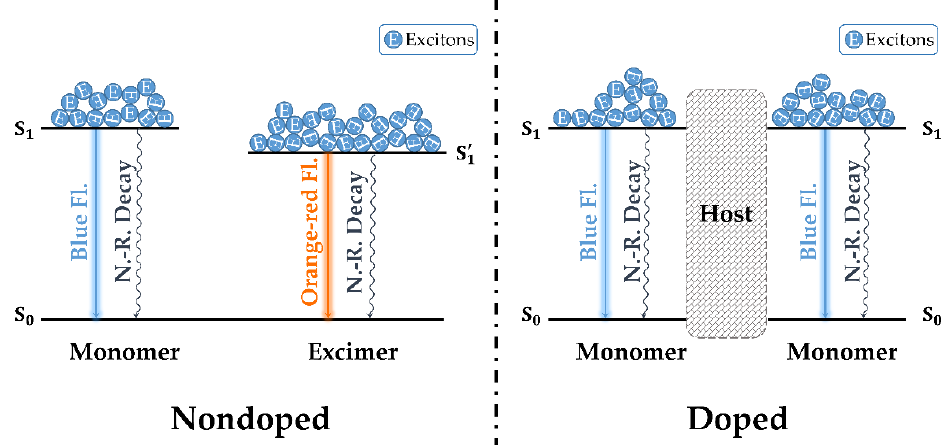
Figure 7. A proposed mechanism illustrating the discrepancies of electroluminescence between non- doped and doped devices.